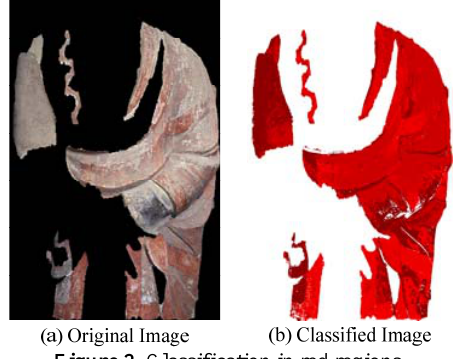
Figure 2 . Classification in red